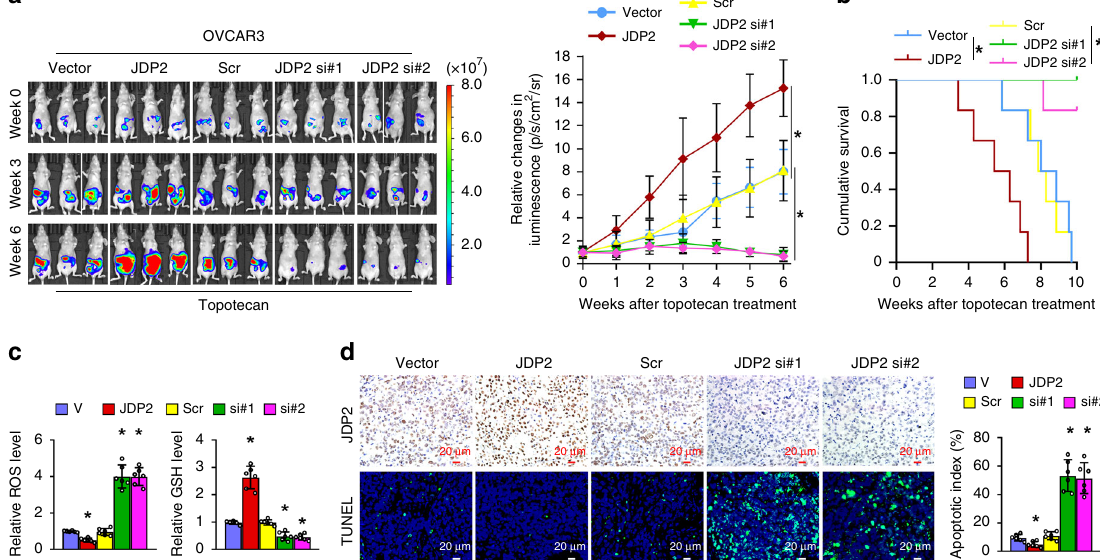
Fig. 9 JDP2 confers resistance to genotoxic stress on cancer cells in vivo. a Representative images of tumor-bearing nude mice inoculated intraperitoneally with the indicated cells in response to Topotecan chemotherapy at the indicated times (left), and the relative change in the bioluminescence signal of intraperitoneal tumors in nude mice in response to Topotecan chemotherapy (right). n = 6 animals per group. b Kaplan – Meier survival of mice inoculated intraperitoneally with the indicated cells. n = 6 animals per group. c Relative levels of GSH (left) and ROS (right) in the indicated xenograft tumors. d IHC staining of JDP2 expression and TUNNEL analysis (left) and quanti fi cation (left) of the apoptotic index in the indicated xenograft tumors. Scale bar, 20 μ m. Each error bar in panels c and d represents the mean ± SD of three independent experiments. * P < 0.05. Student ’ s two-tailed t test. Source data of Fig. 9a – d are provided as a Source Data fi